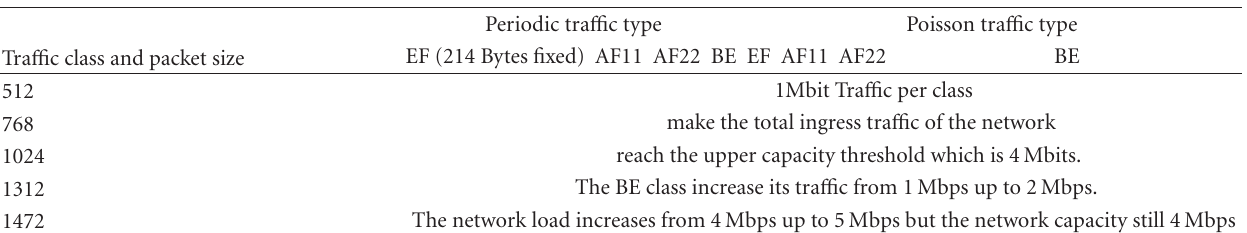
Figure 7: HTB packet scheduler and Di ff Serv supported classes [10]. Table 5: Initial test